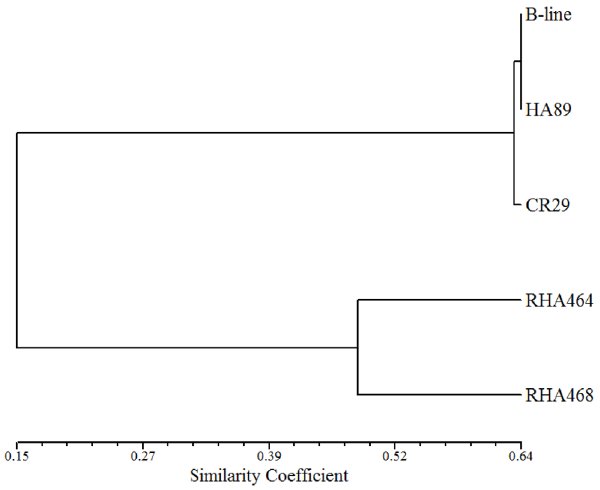
Figure 1. Genetic relationship of mapping parents. Dendogram of the 5 sunflower parents of the three mapping populations based on unweighted pair-group method with arithmetic averages clustering analysis